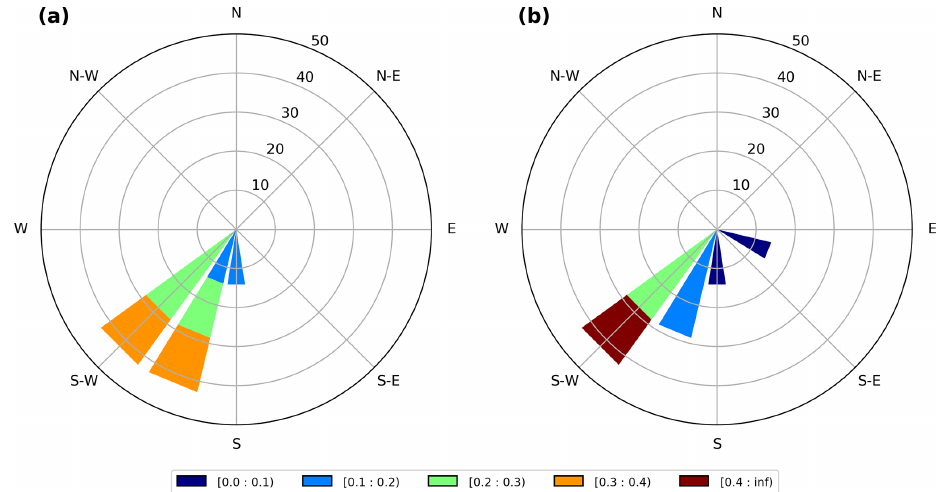
Figure 2. Current roses of sea surface velocities at Kafireas Strait: (a) winter and (b) spring. Colors in units (m/s) and isocontours (%).